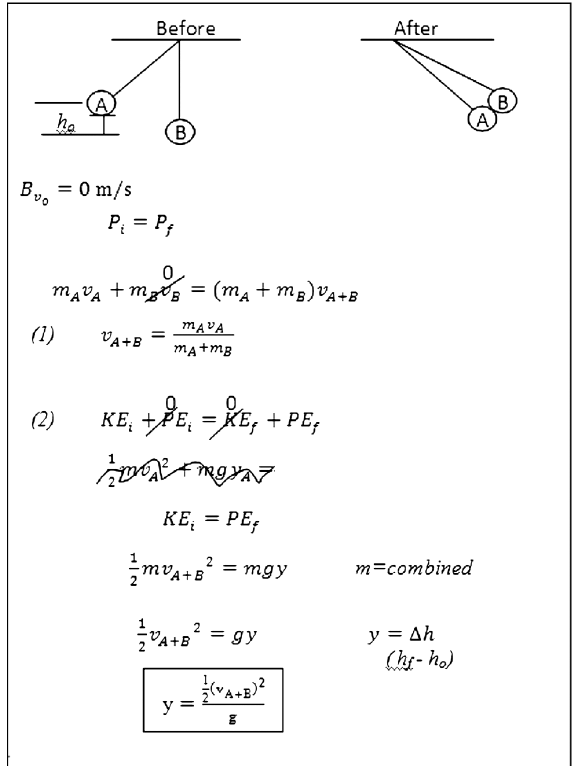
FIG. 5. Students A’s answer to the putty